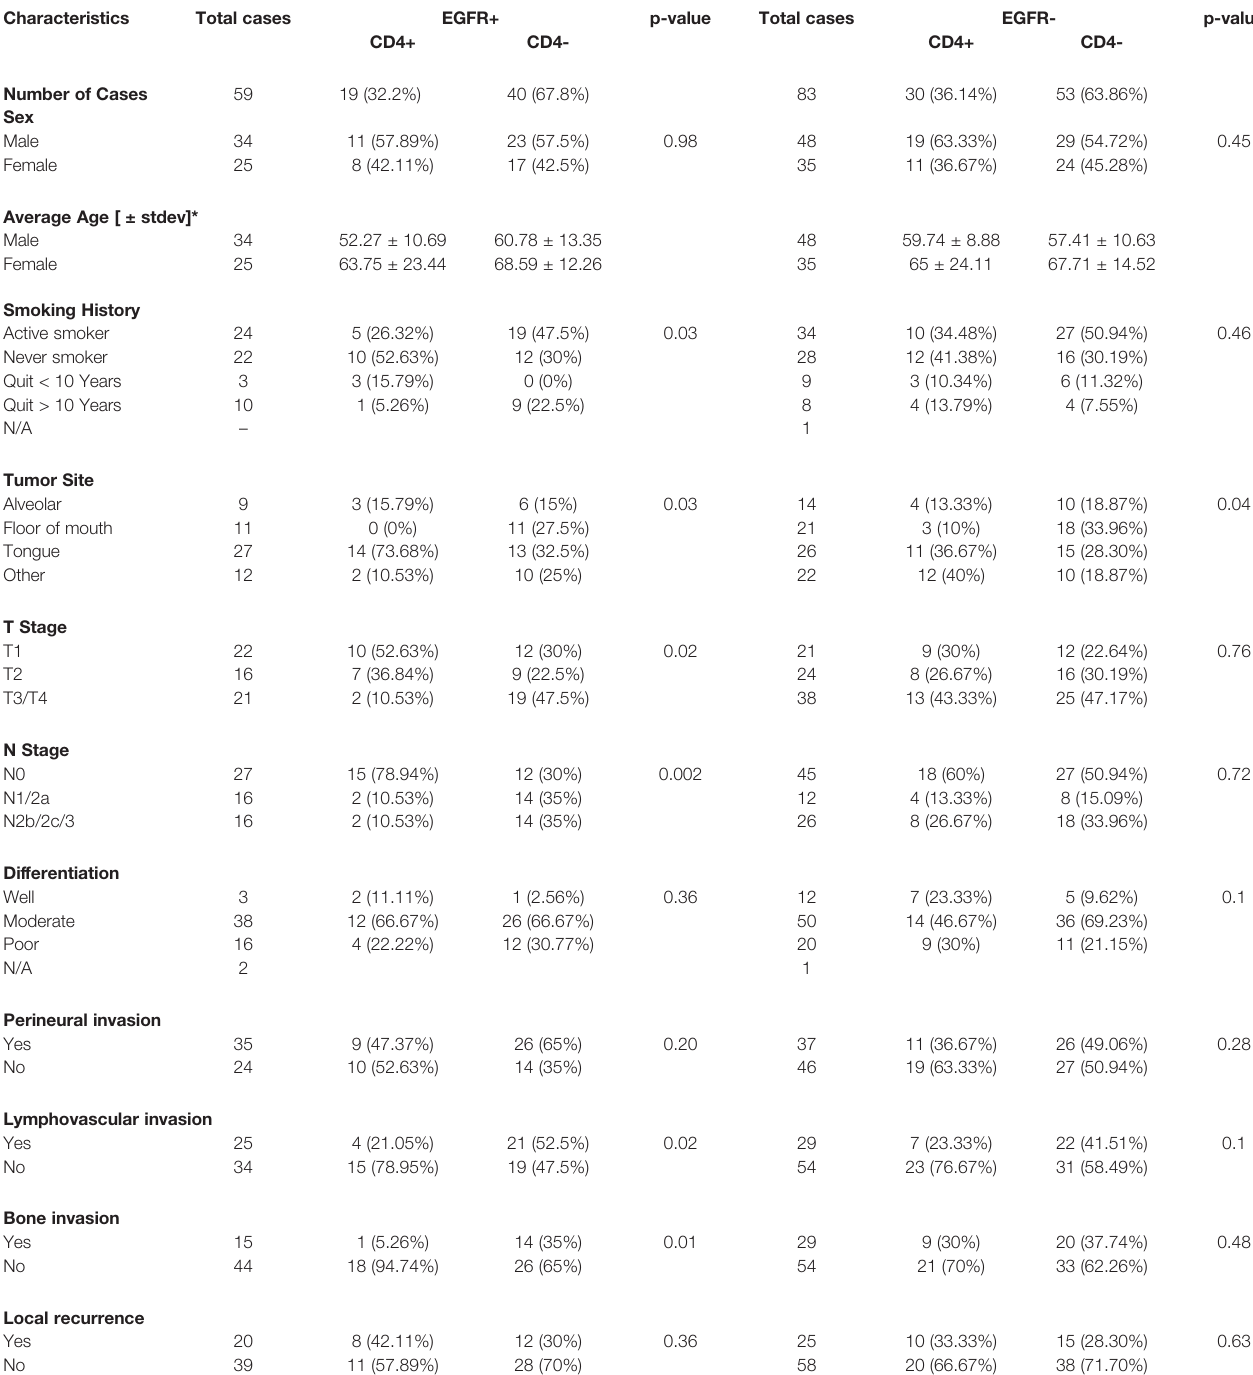
TABLE 4 | Clinicopathological features of patients based on EGFR/CD4 status.